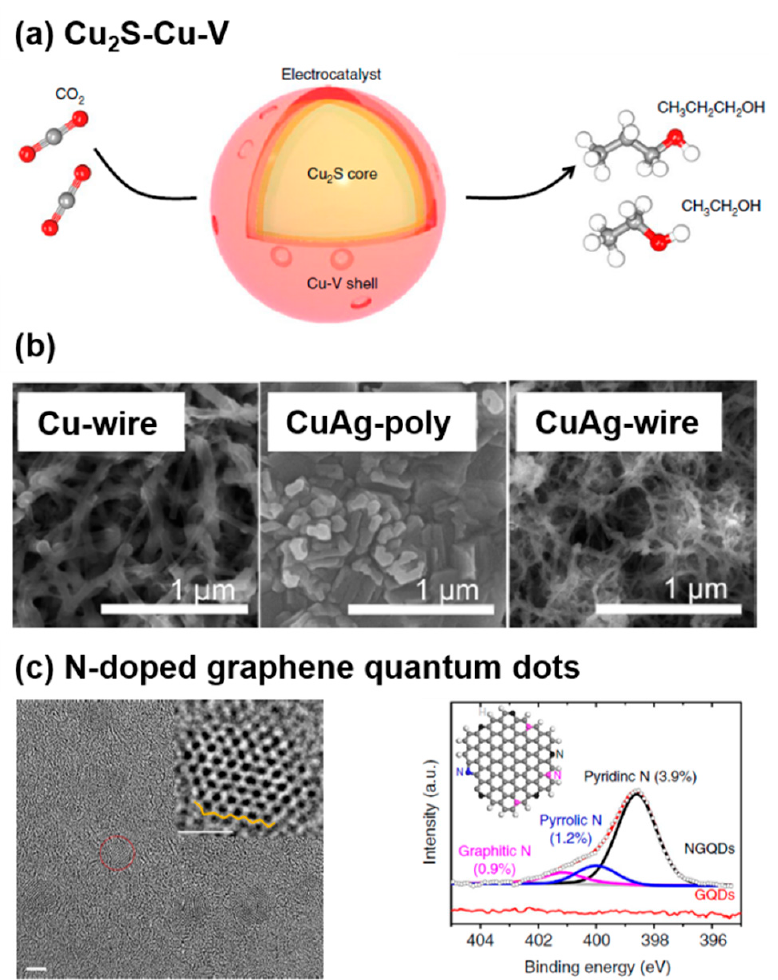
Figure 15. Various catalytic materials examples for a gas diffusion electrode in a microfluidic cell to target hydrocarbon production. ( a ) Cu 2 S-Cu-V core-shell, ( b ) Cu and CuAg with different forms, and